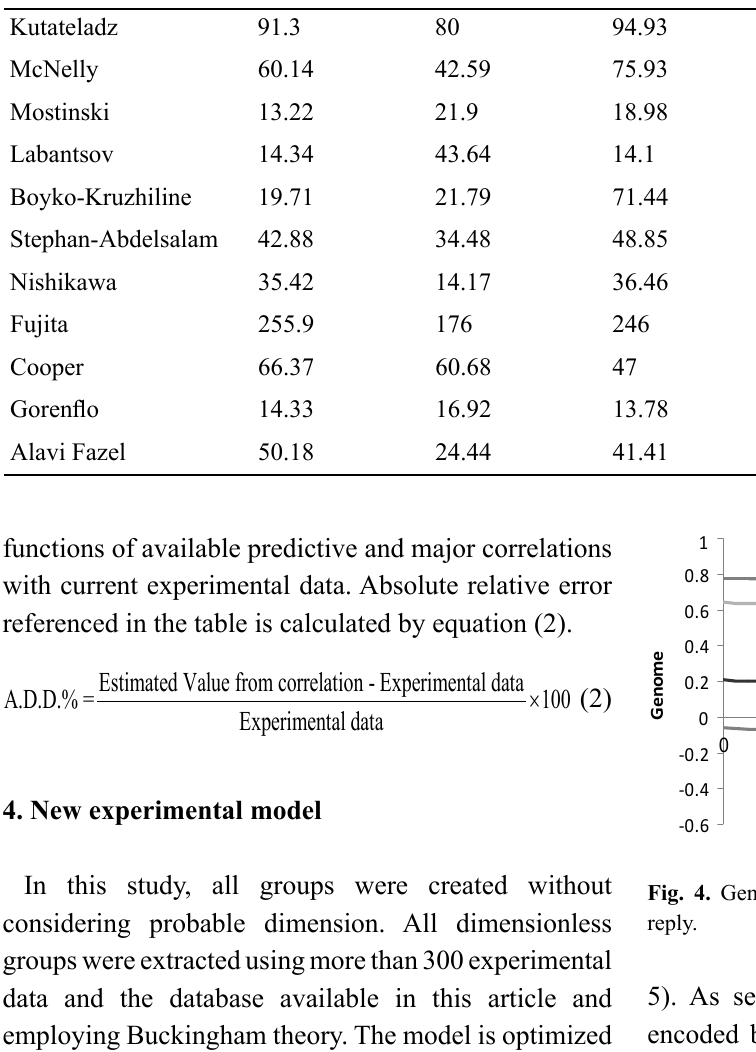
experimental values and values predicted by the proposed model that represents good overlap of the model with experimental data.